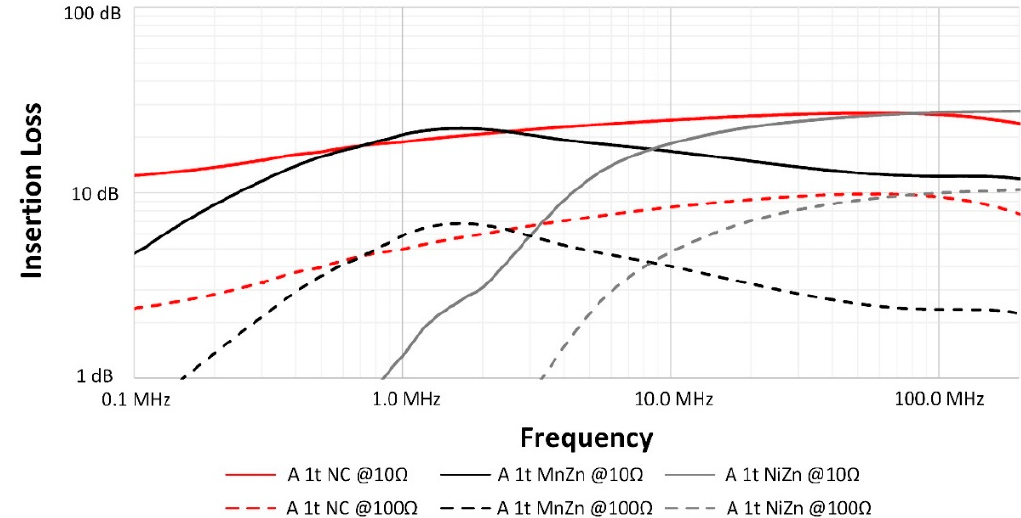
Figure 15. Extrapolation of the measured insertion loss for systems with an impedance of 100 Ω and 10 Ω , considering one turn for NC, MnZn and NiZn sleeve ferrite